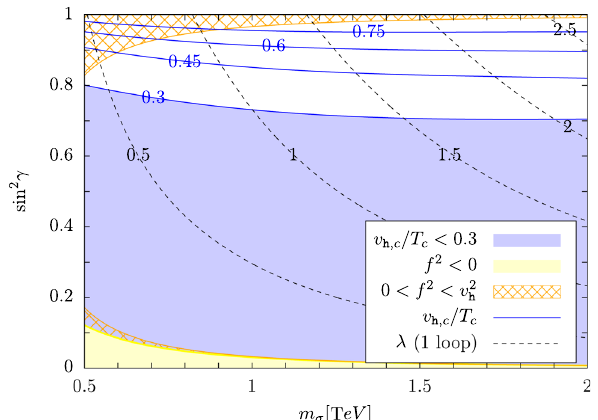
Fig. 6 Strength of the EW phase transition ( v h , c / T c ) as function of the singlet mass ( m σ ) and the mixing angle (sin 2 γ ). The blue solid lines correspond to v h , c / T c = 0 . 3 , 0 . 45 , 0 . 6 , 0 . 75. In addition, the black dashed lines depict λ = 0 . 5 , 1 , 1 . 5 , 2 , 2 . 5, calculated with the one-loop effective potential. According to the criterion of Ref. [82], in the region where λ (cid:3) 1 . 5, the one-loop analysis of the phase transition breaks down due to higher loop